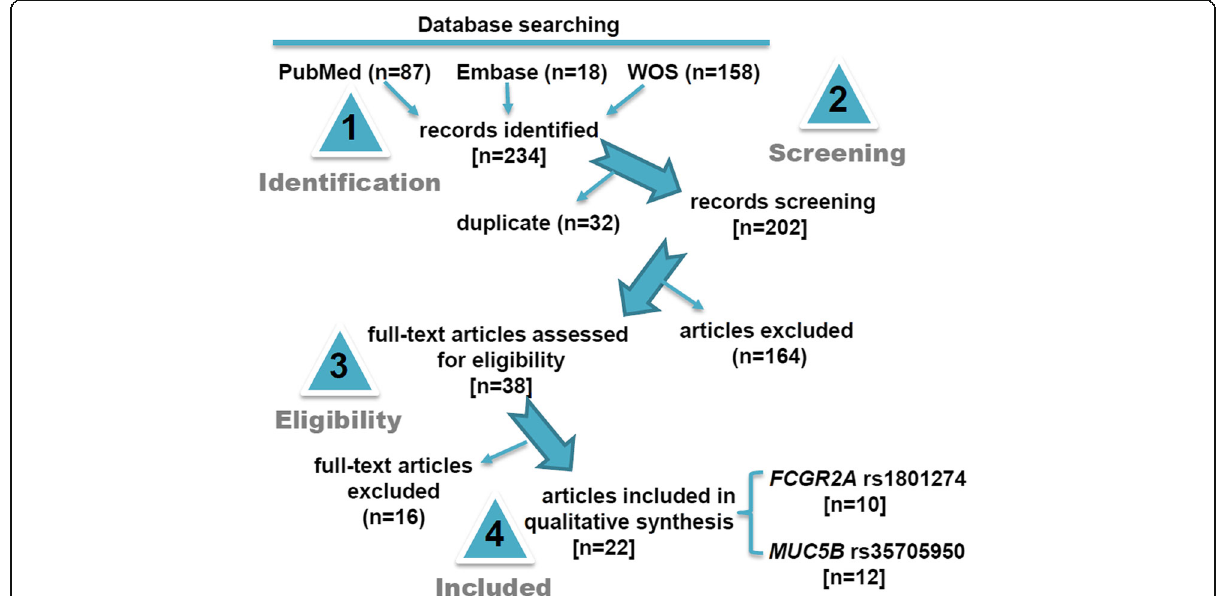
Fig. 1 Flow diagram of eligible case-control study